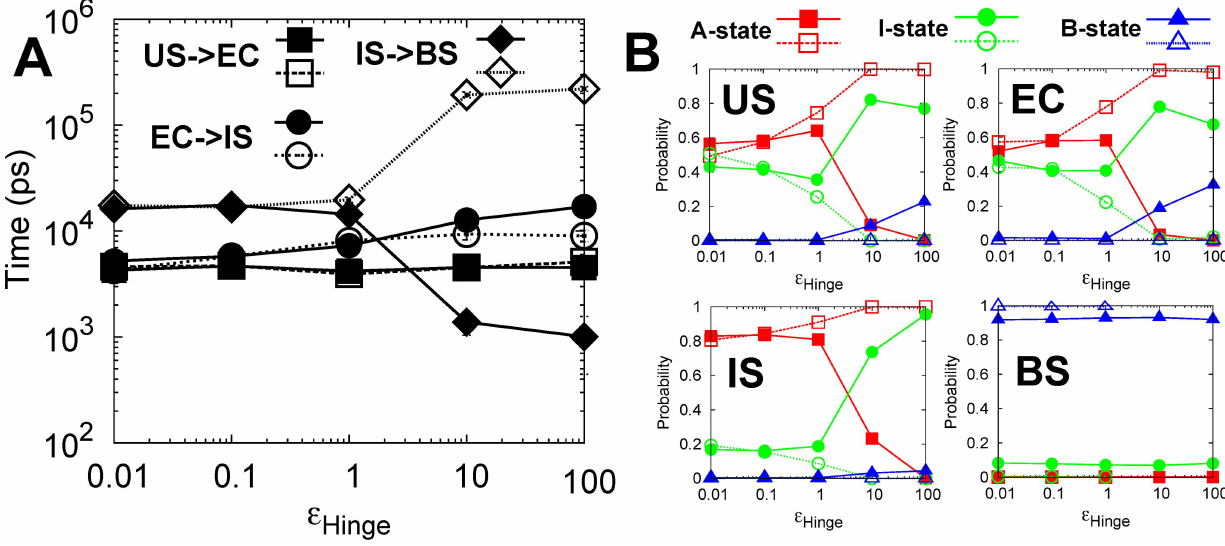
Figure 6. MPT and the conformational dynamics of DPO4 change with the flexibility of the linker. E Hinge is the parameter which controls the flexibility of the linker. There are two groups of E Hinge shown. The filled symbols correspond to the linker biased to the B-state while the empty symbols correspond to the linker biased to the A-state. (A) MPT as a function of E Hinge . (B) The conformational population distribution of the A-, I- and B-state of DPO4 in the US, EC, IS and BS with different E Hinge . Notice that when E Hinge equals 10.0 and 100.0, the BS cannot be observed in the simulations when the linker is biased to the A-state. MPT is calculated as the largest observation time. The error bar represents the standard error of the corresponding